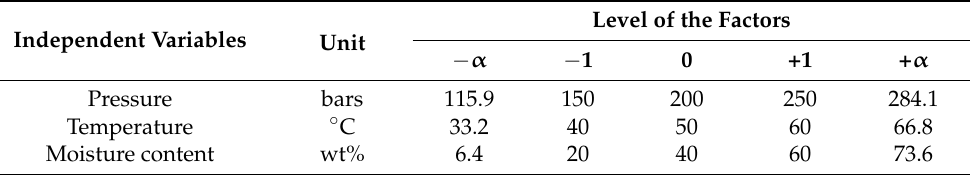
Table 1. Independent variables and their level used ( α : 1.68) in central Composite Rotatable Design (CCRD) for the optimization of supercritical CO 2 extraction of